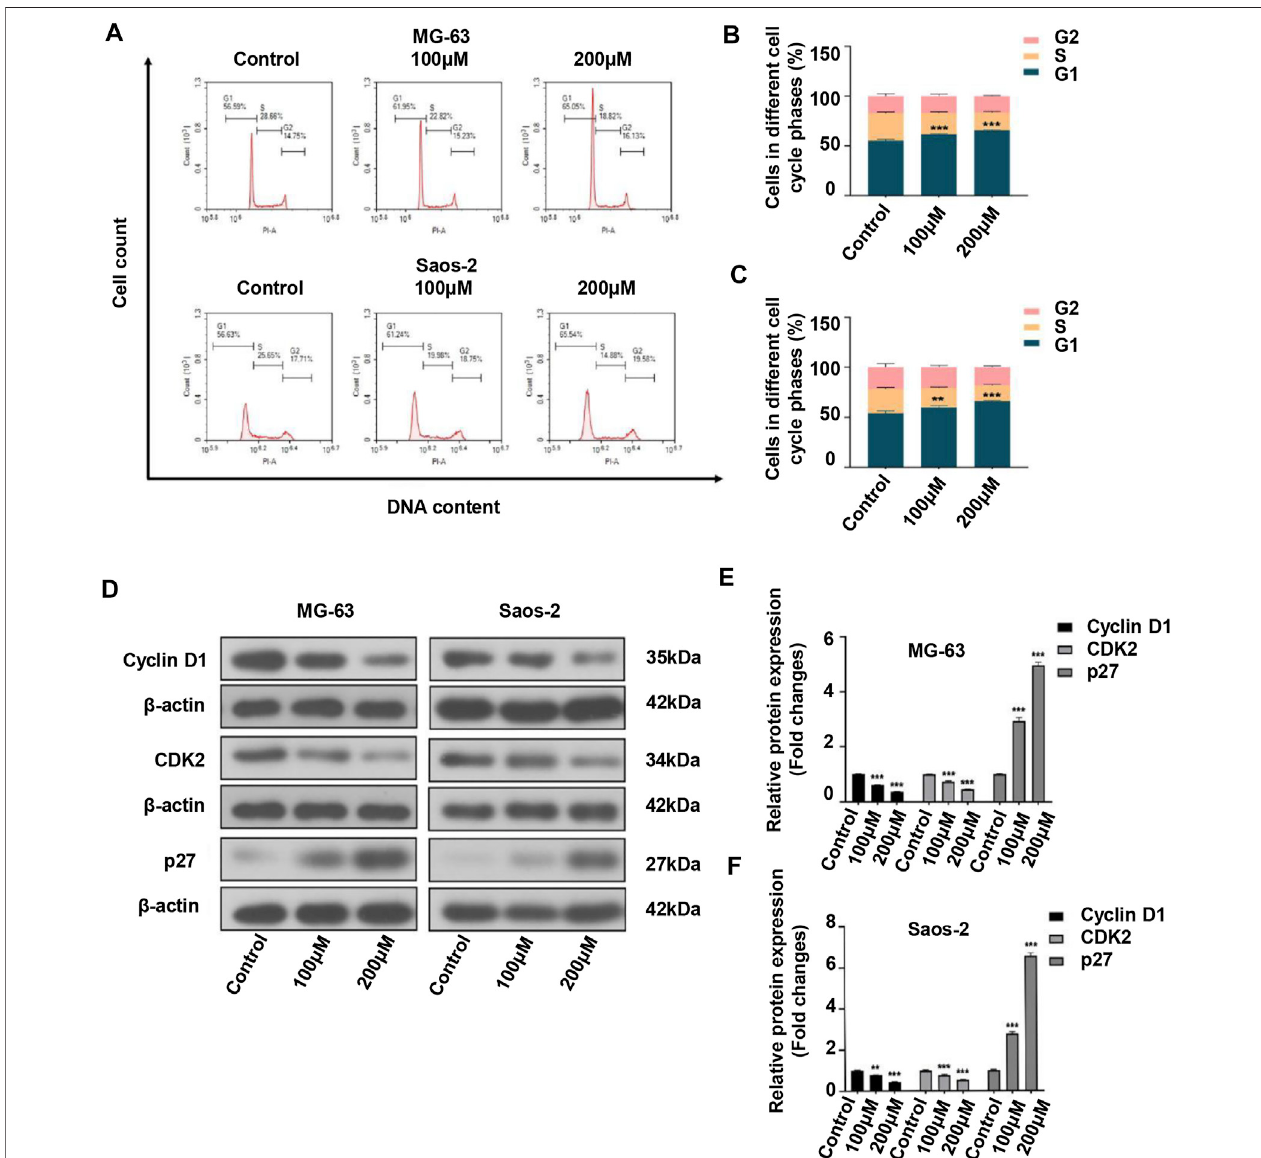
FIGURE 2 | Peiminine induced cell cycle arrest at the G0/G1 phase in osteosarcoma cells. (A – C) Peiminine treatment promoted G0/G1 cell cycle arrest as determined by fl ow cytometry. (D) Western blot analysis of the expression of the cell cycle-associated proteins cyclin D1, CDK2, and p27. (E,F) Quantitative analysis of the levels of cell cycle-associated proteins ( n (cid:2) 3). β -actin served as the control. ** p < 0.01, *** p < 0.001.